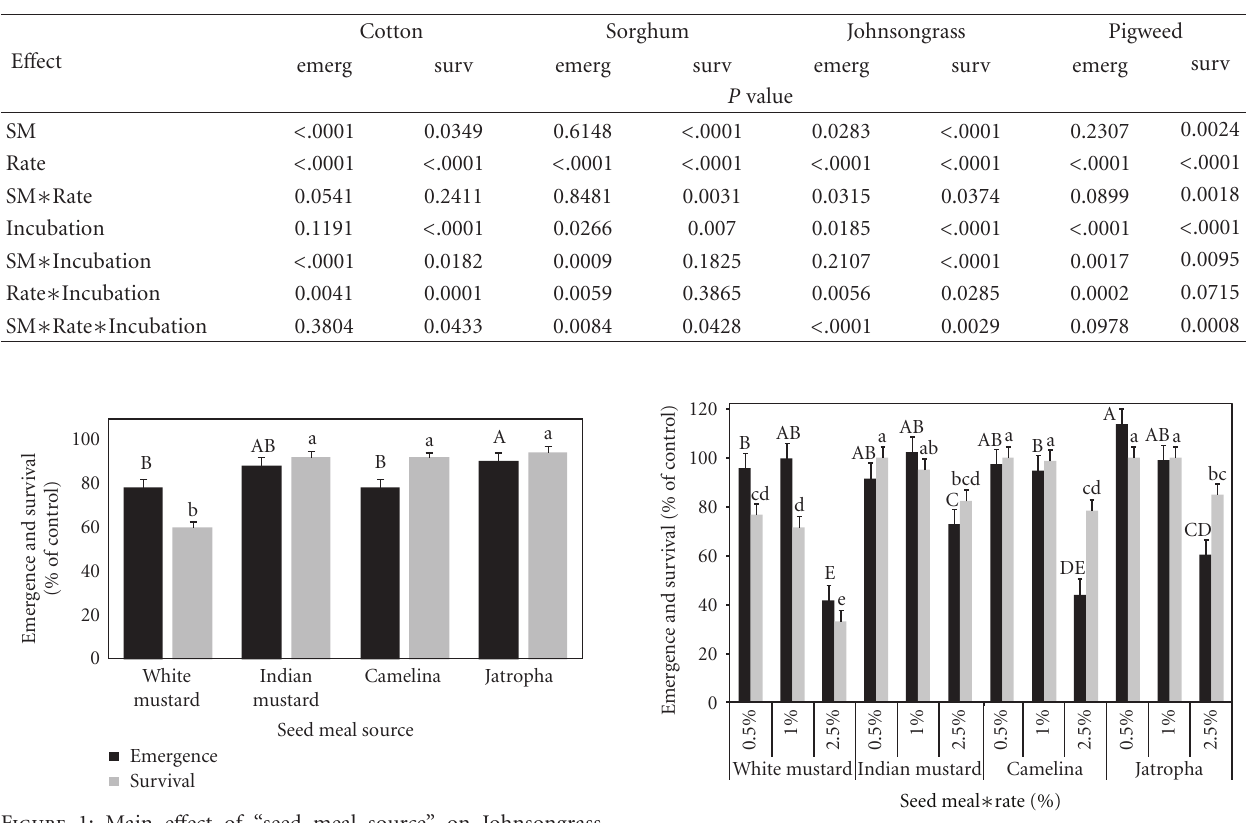
Figure 1: Main e ff ect of “seed meal source” on Johnsongrass emergence and survival. Means within emergence or survival followed by the same letter are not di ff erent at P < 0 . 05 by Fisher’s protected LSD. Uppercase letters separate emergence means and lowercase letters separate survival means. Data are means (four replications) ± SE.